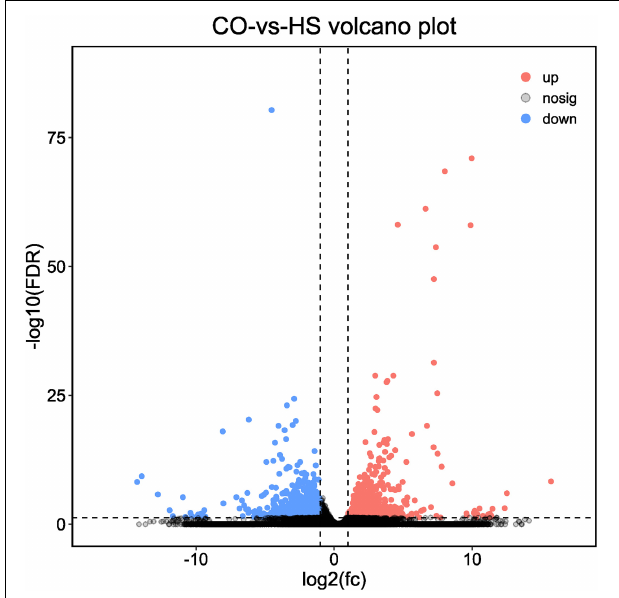
FIGURE 2 | Volcano scatter plots of differentially expressed genes (48 h_HS vs. CO). Red points represent significantly up-regulated genes (false discovery rate, FDR < 0.05 and | log 2 fold-change| (cid:61) 1). Blue points represent significantly down-regulated genes (FDR < 0.05 and | log 2 fold-change| (cid:61)